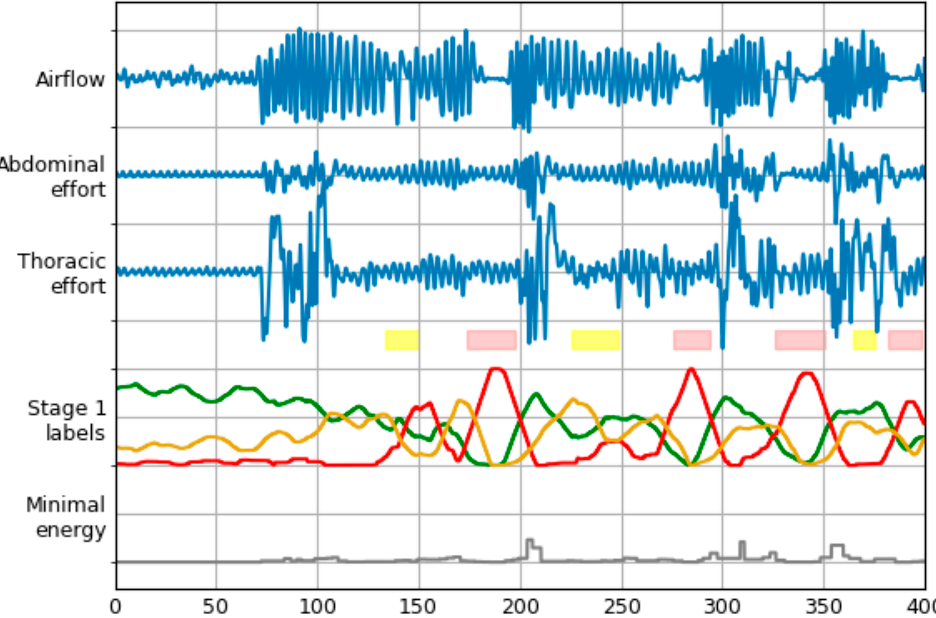
Figure 4. Signals and labels from Figure 2 with labels timeline produced by Stage 1 LSTM. Normal, apnea and hypopnea beginning classes are represented with green, red and yellow lines, respectively. Grey line represents the fourth signal that is input to Stage 2 LSTM.